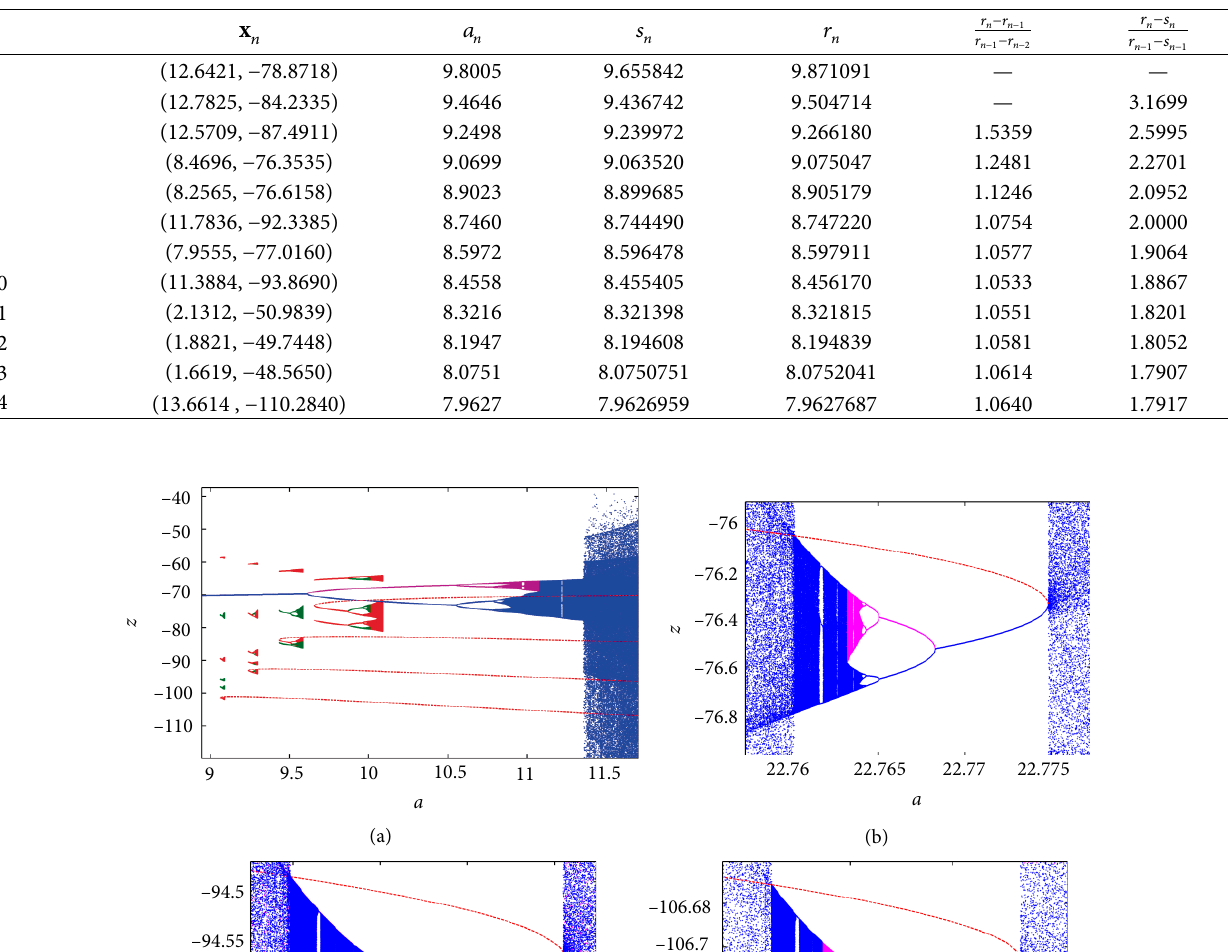
Table 1: Sequence of bifurcation points.